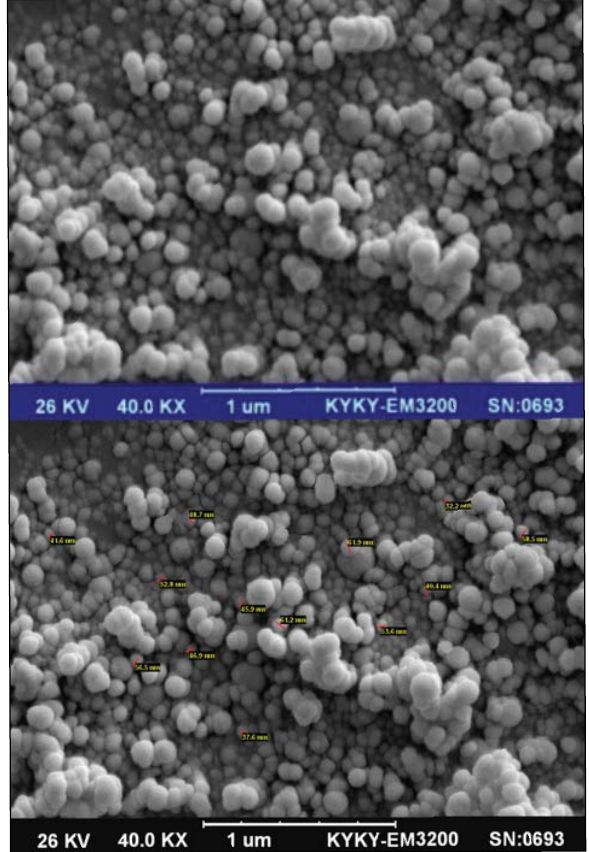
Fig. 3. The SEM image of nano-Rb